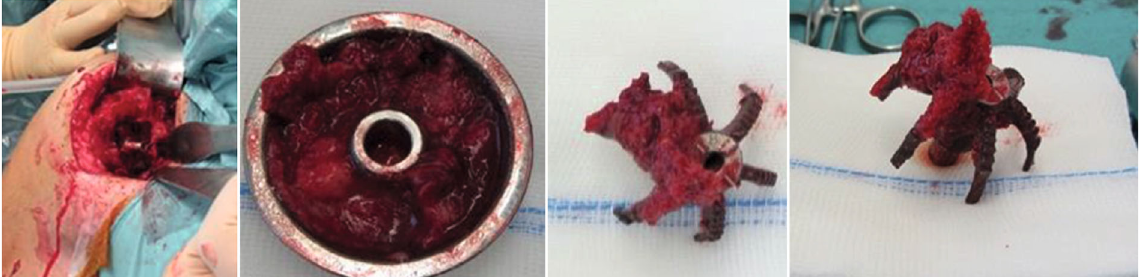
Figure 2: Corolla in situ, back of the humeral head, and corolla explanted.